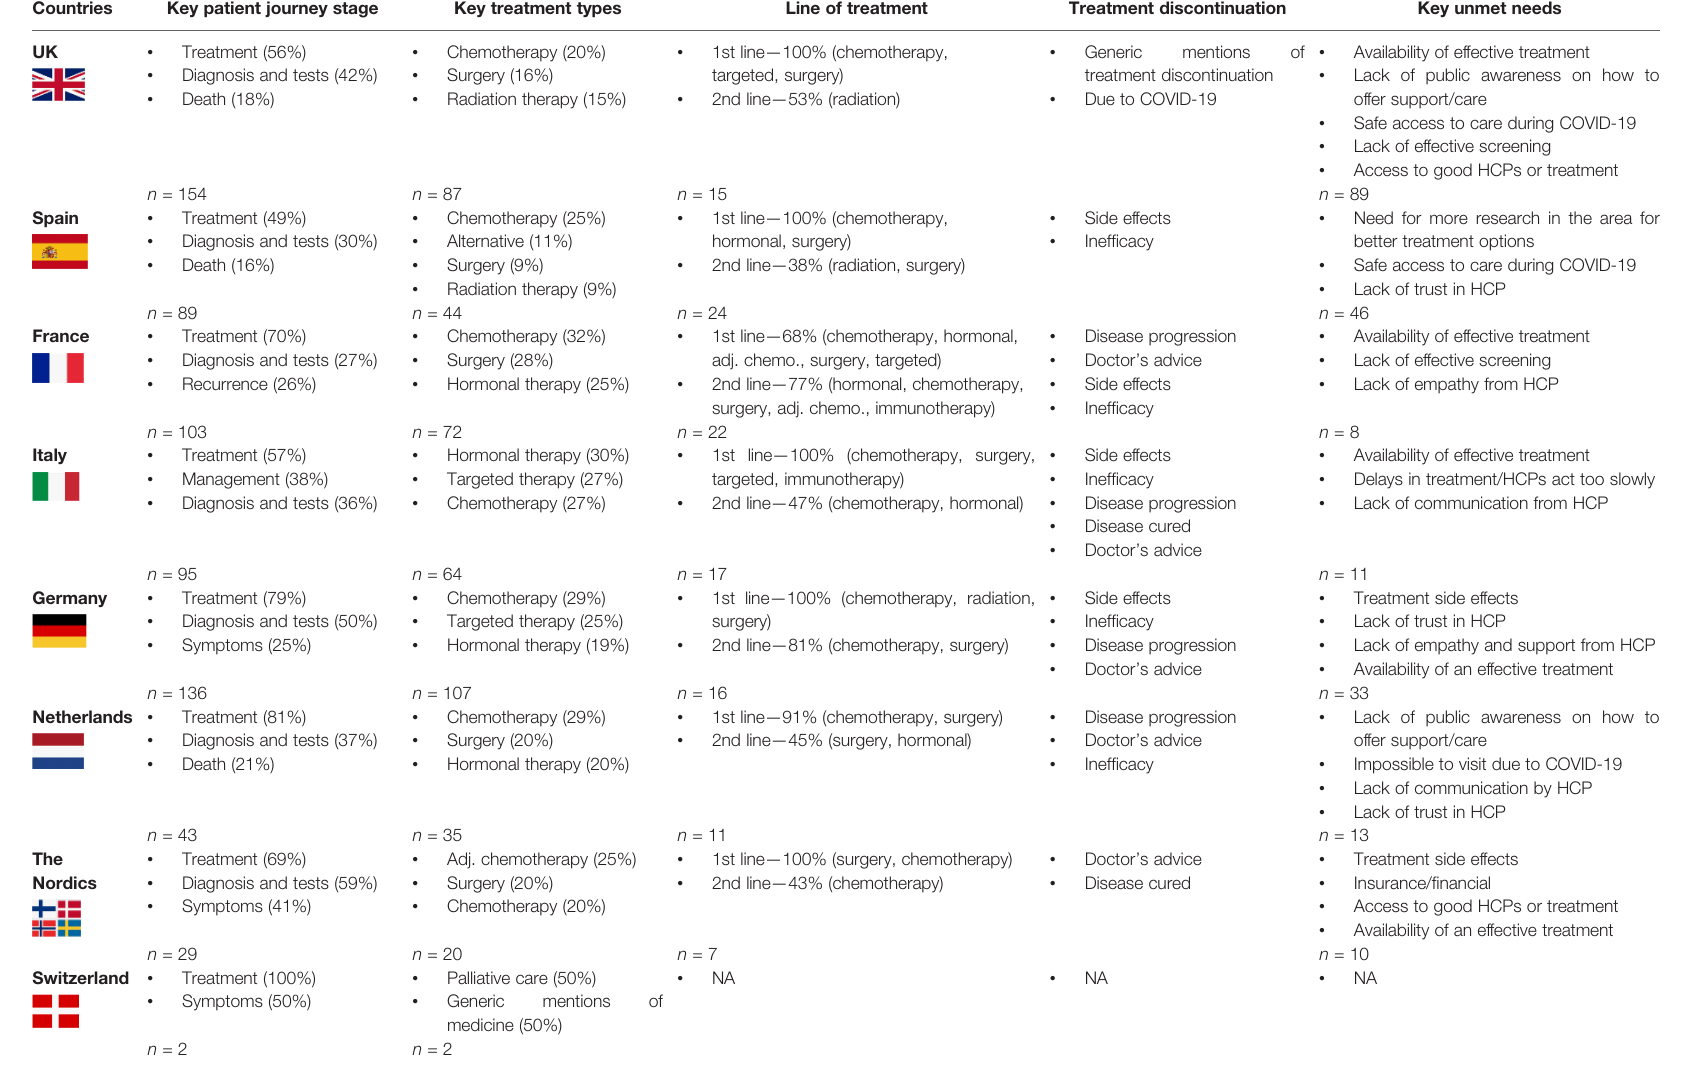
TABLE 2 | Country-speci fi c metrics. Countries Key patient journey stage Key treatment types Line of treatment